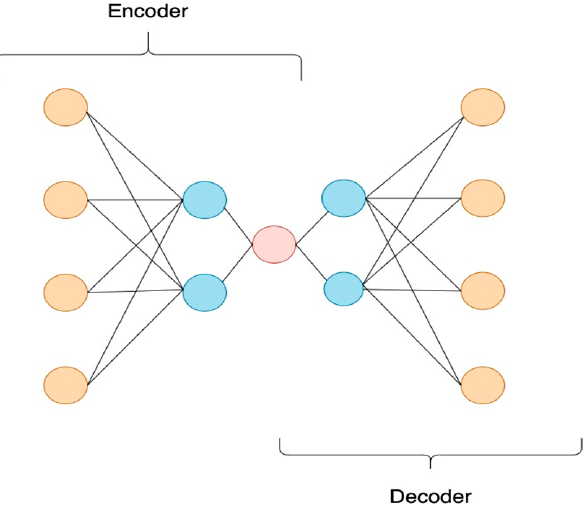
Figure 7. Demonstration of the architecture of a typical Autoencoder.